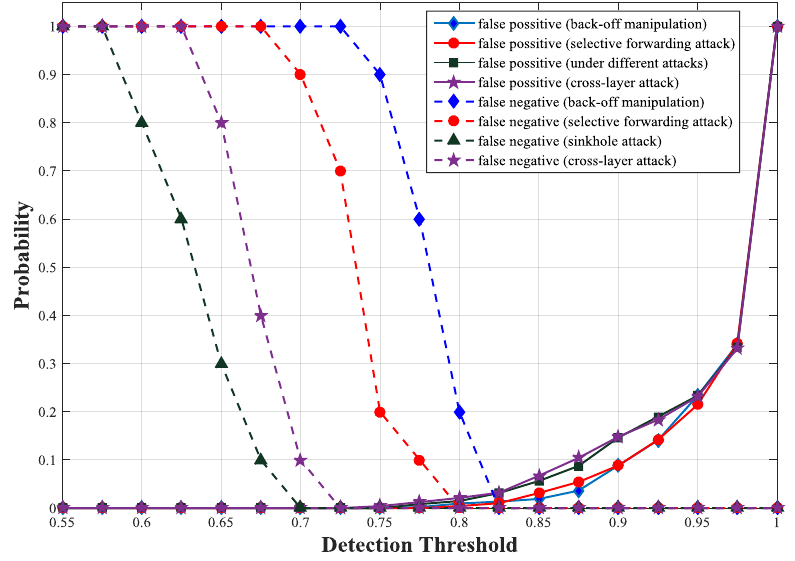
Figure 5. False positive and negative probabilities with different thresholds using simulation .